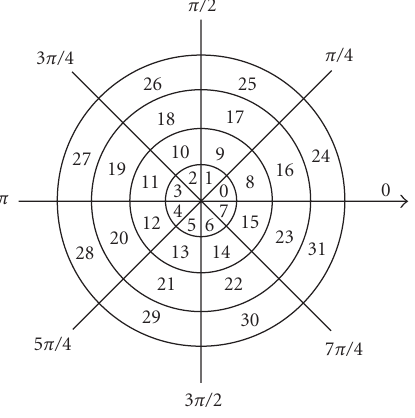
Figure 1: Illustration of a 2D gradient coder ( Δ ρ = 1 / 4, Δ θ = π/ 4).